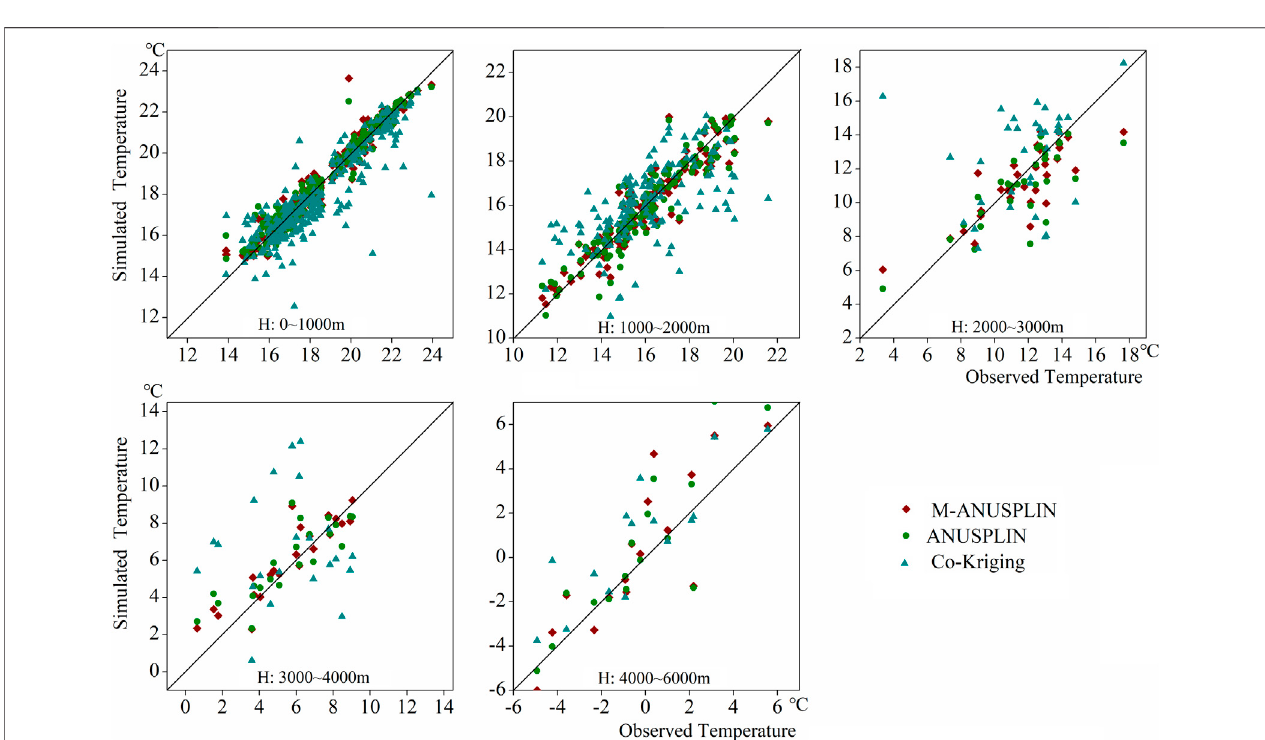
FIGURE 2 | The MAEs of co-kriging, ANUSPLIN, and M-ANUSPLIN models along altitudinal gradients.